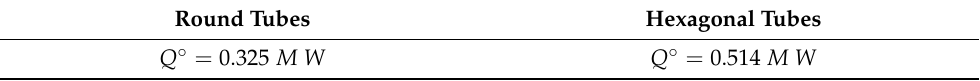
Table 4. CFD heat transfer rates are computed at the optimum fluid